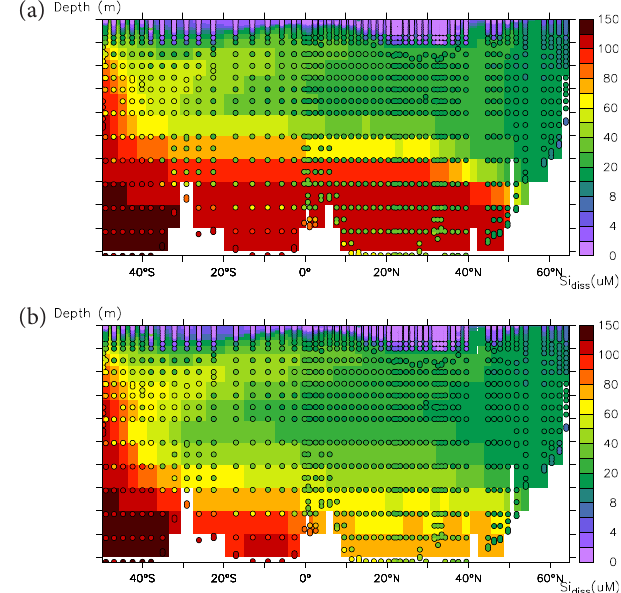
Figure 12. The modelled silicic acid concentration at the West Atlantic GEOTRACES section. Coloured dots are measurements (data from K. Bakker, E. van Weerlee, M. Rijkenberg and H. J. W. de Baar). Both simulated and observed concentrations are in µM (on a non-linear